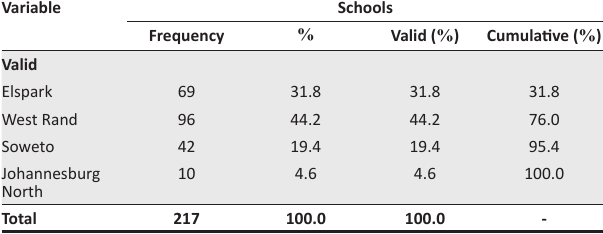
TABLE 4: Distribution of respondents per school.